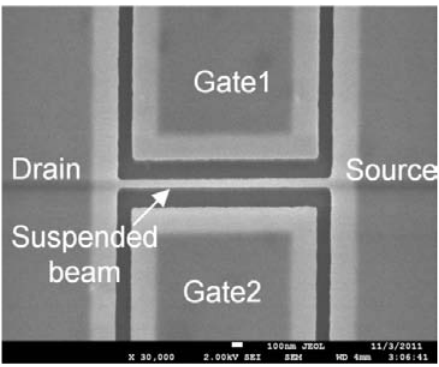
Figure 9. The scanning electron microscope (SEM) view of the fabricated in-plane resonant nano-electro-mechanical (IP R-NEM) sensor.